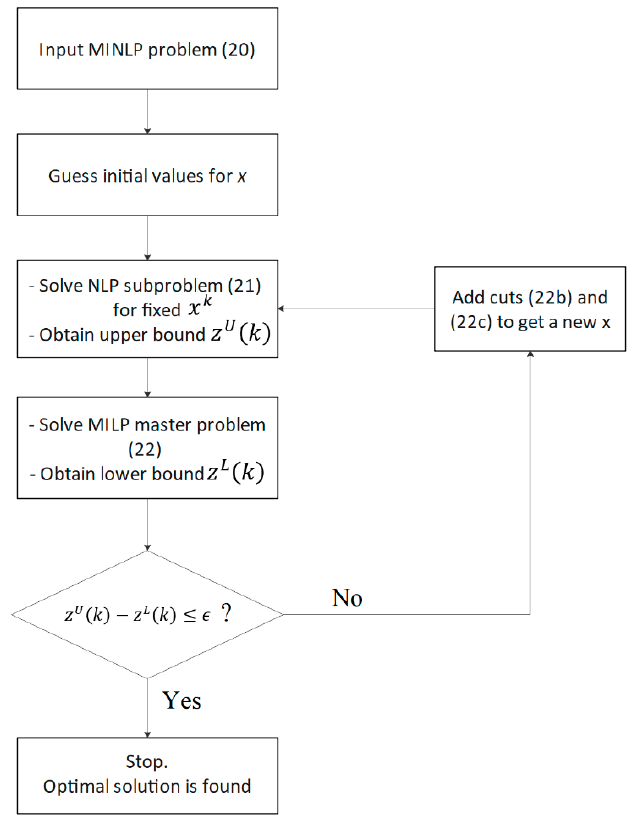
Figure 7. The outer approximation algorithm.